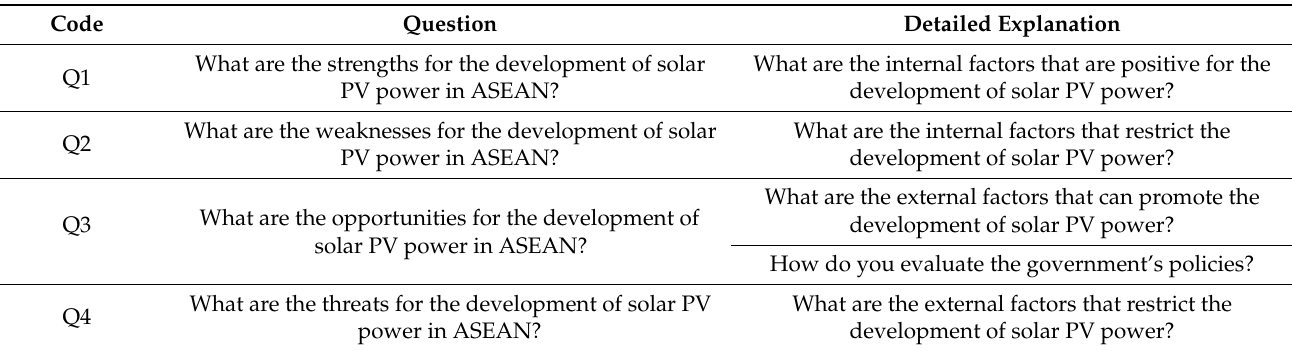
Table 1. Main questions for interviews.